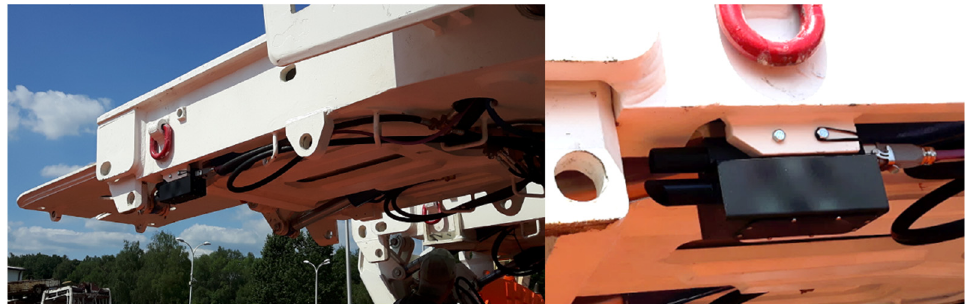
Figure 9. Model of the SSMS-S sensor installed on the BW 24/44 POz roof support canopy during preparatory work for the mining process, at the manufacturer’s site.